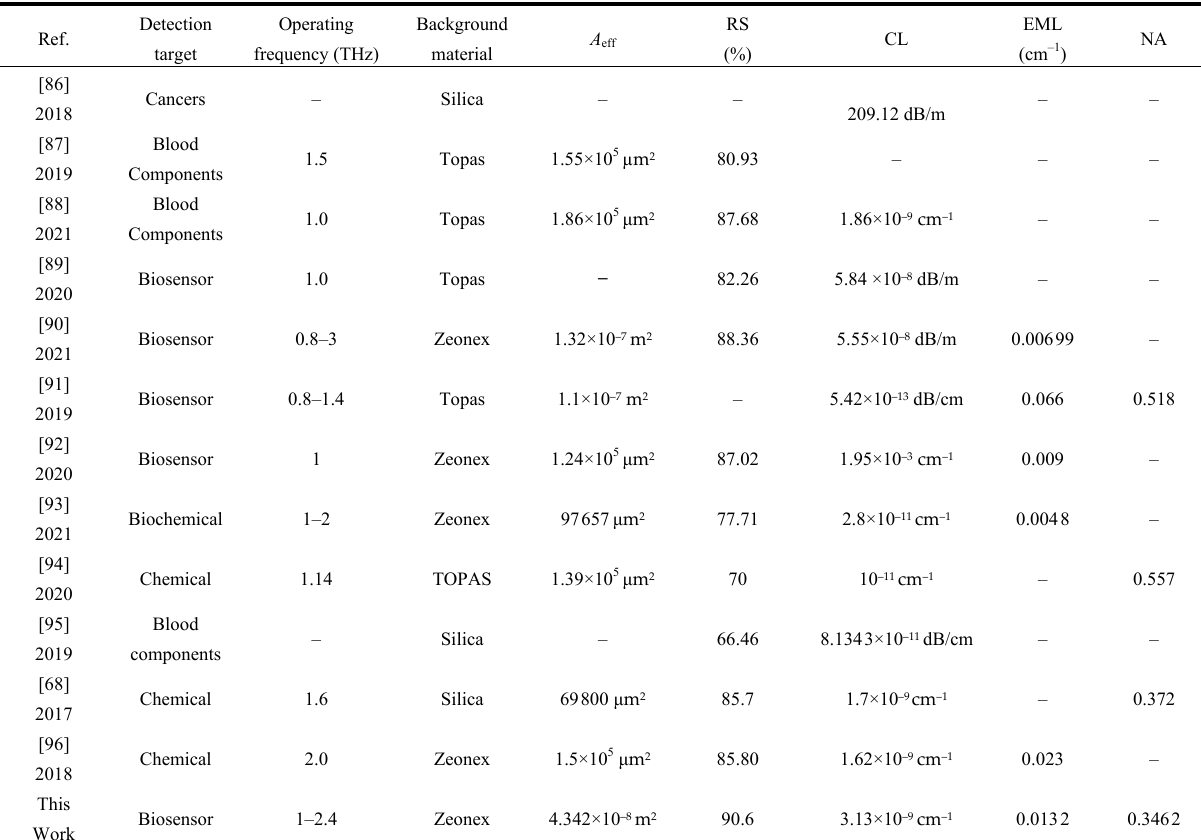
Table 4 Comparison between the proposed tuberculosis sensor and biosensors based on photonic crystal fiber.